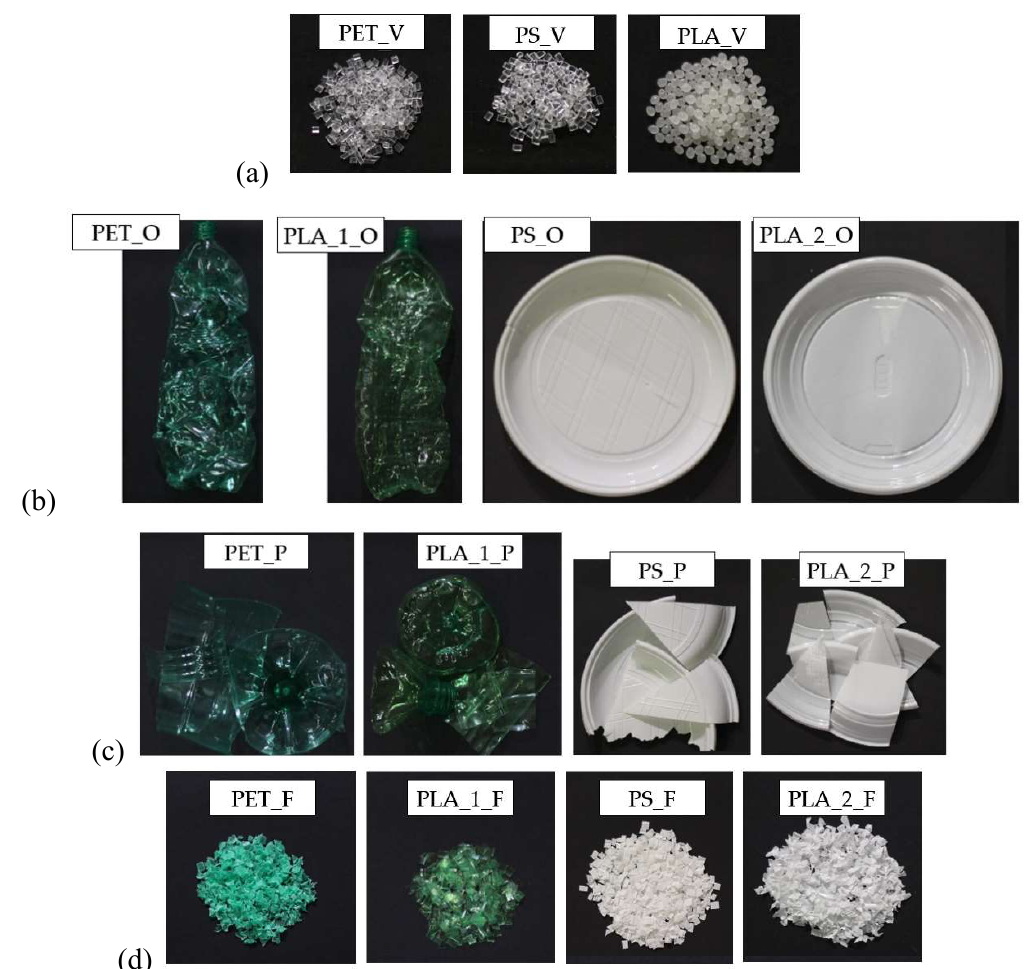
Figure 1. Images of samples of ( a ) virgin materials, ( b ) waste in original shape, ( c ) waste in pieces and ( d ) waste in flakes. ( d ) waste in